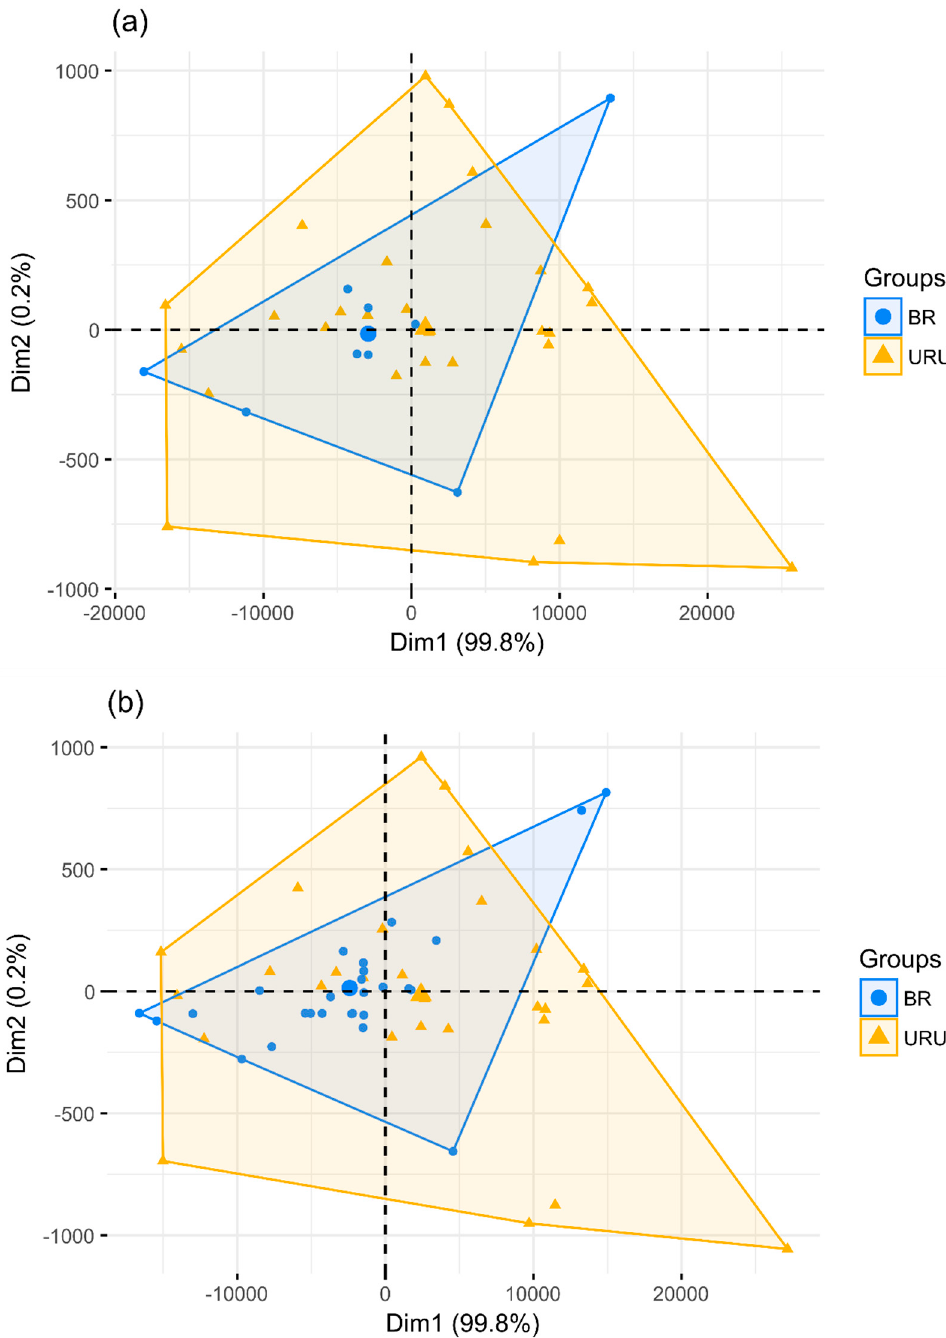
Figure 2. Visual separation of wines based on PC1 (principal component) and PC2. ( a ) The original data; ( b ) the synthetic data added to the original data.